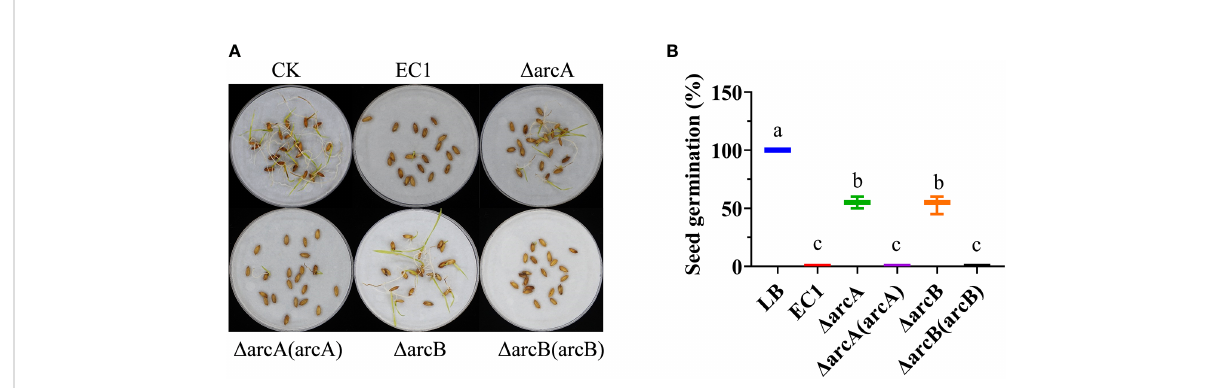
FIGURE 5 The arcA and arcB deletion mutants showed reduced pathogenicity and ability of infection on rice seeds. (A) Rice seed germination inoculated with strain EC1 and its derivatives. Twenty rice seeds were treated with EC1 and its derivatives, respectively, and the experiment was repeated twice. (B) Germination rates of rice seeds treated with strain EC1 and its derivatives. Statistical analysis was performed on each group of data and signi fi cantly different values (analysis of variance, p < 0.05) are indicated by different